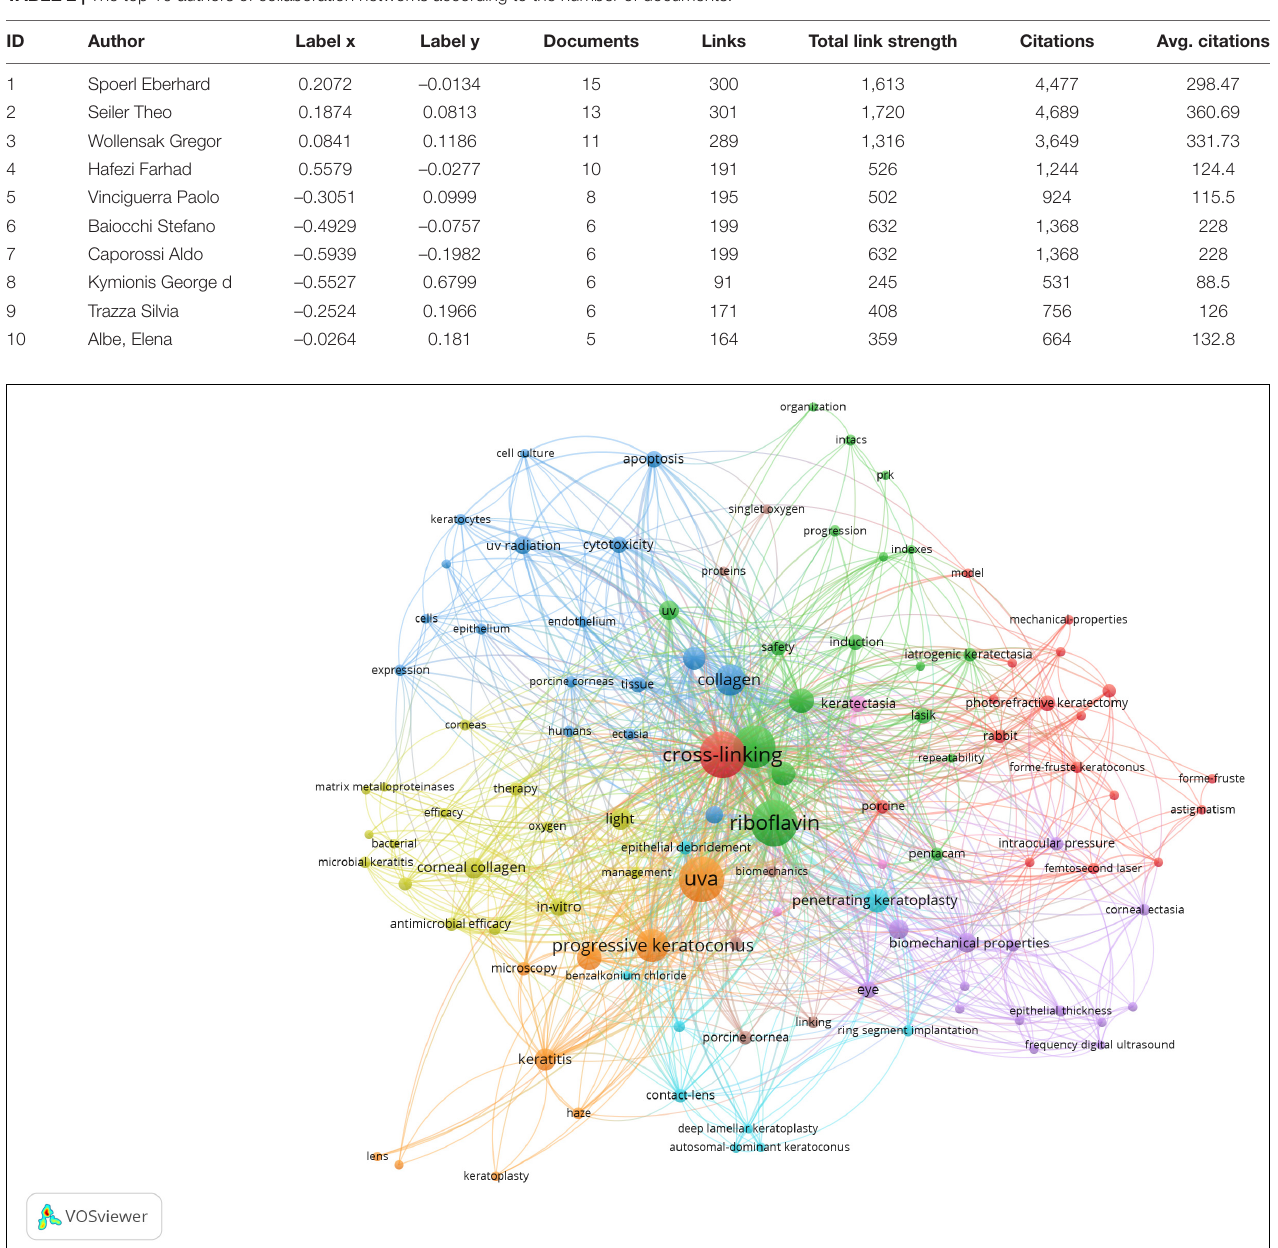
TABLE 2 | The top 10 authors of collaboration networks according to the number of documents.